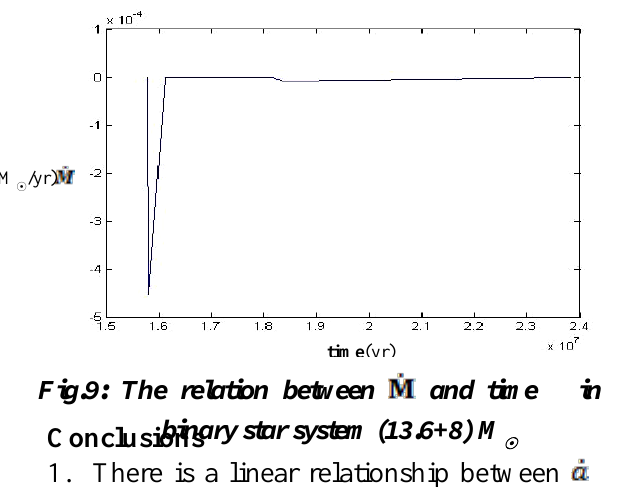
Fig.9: The relation between and time in binary star system (13.6+8) M